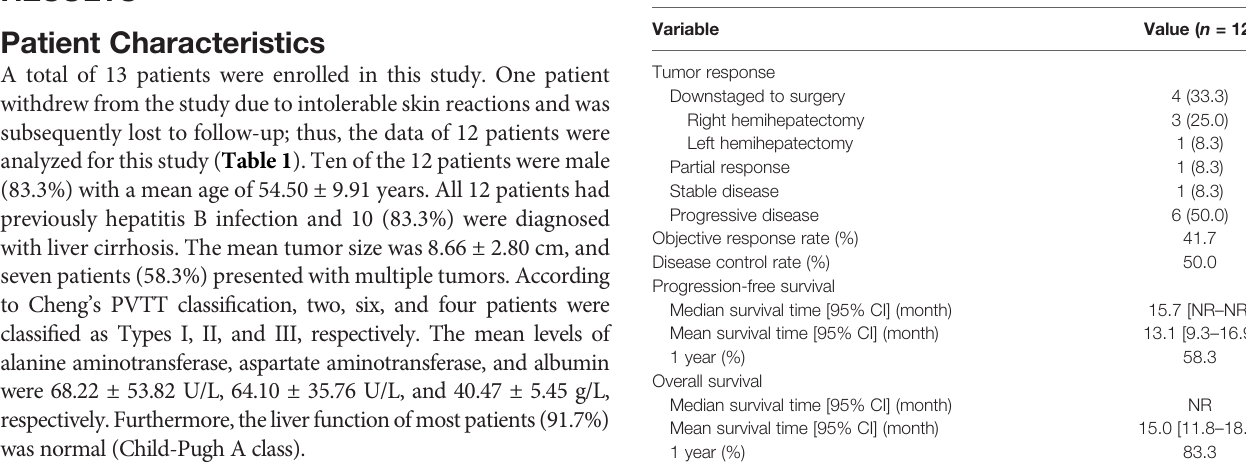
TABLE 2 | Ef fi cacy of combination therapy in advanced HCC with